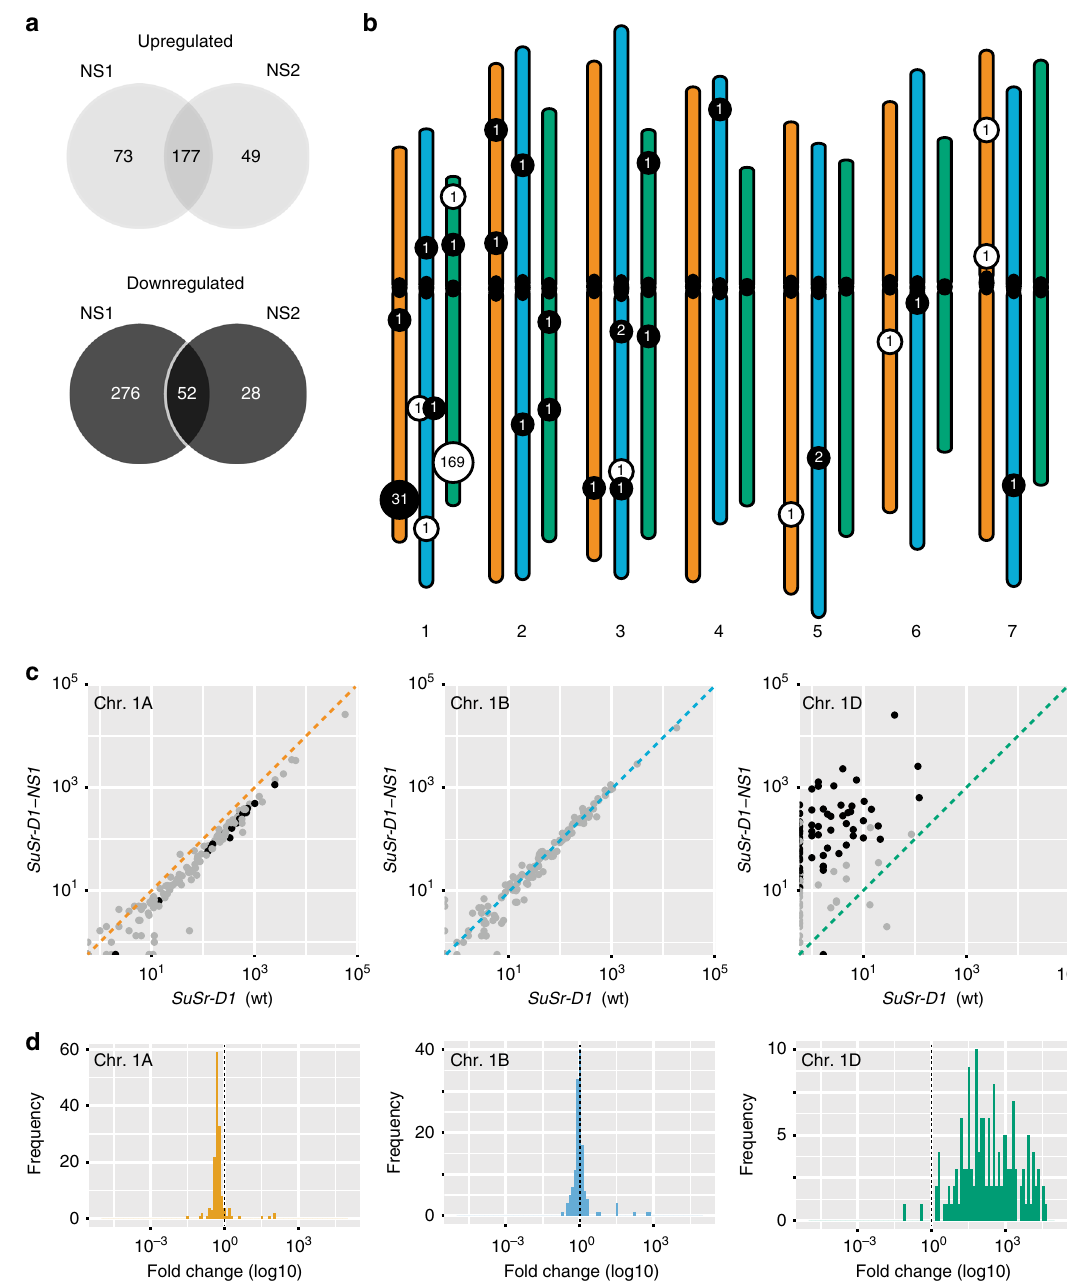
Fig. 4 Mutation in SuSr-D1 differentially regulates homeologous regions on chromosome group 1. a Venn diagrams showing RNAseq-based differentially expressed (DE) genes between wild-type (CTH) and SuSr-D1 mutants NS1 and NS2 using a false discovery rate (FDR) of 5%. Top, upregulated genes (higher expression in mutant relative to wild-type). Bottom, downregulated genes (lower expression in mutant relative to wild-type). b Physical distribution of DE genes across the chromosome of wheat. The majority (87%) of DE genes localize to homeologous regions on chromosomes 1A and 1D. Upregulated and downregulated genes are shown in white and black fi lled circles, with A, B, and D genomes shown in orange, blue, and green, respectively. Below, Triticeae chromosome groups. c Pair-wise plots of leaf expression levels for homeologous chromosome group 1 regions. Black circles represent differentially expressed genes (FDR 5%), whereas gray circles are not differentially expressed. Diagonal lines indicate equal expression levels. x -axis (wild- type, SuSr-D1 ) and y -axis (mutant, SuSr-D1-NS1 ) are log 10 -transformed based on transcripts per million. d Histograms of fold change in gene expression for all genes shown in Fig. 4c with non-zero expression in both wild-type and mutant